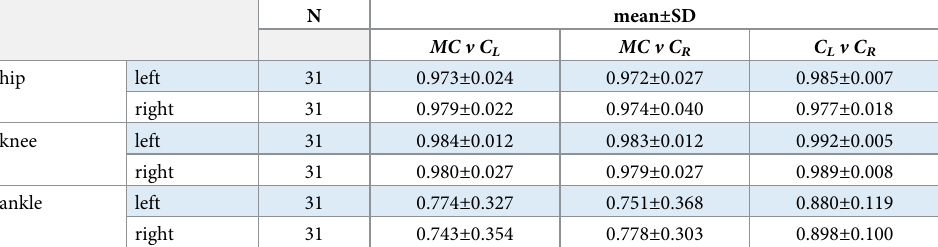
Table 7. Cross-correlations of joint angles. MC : motion capture; C L : OpenPose left-side view; C R : OpenPose right- side